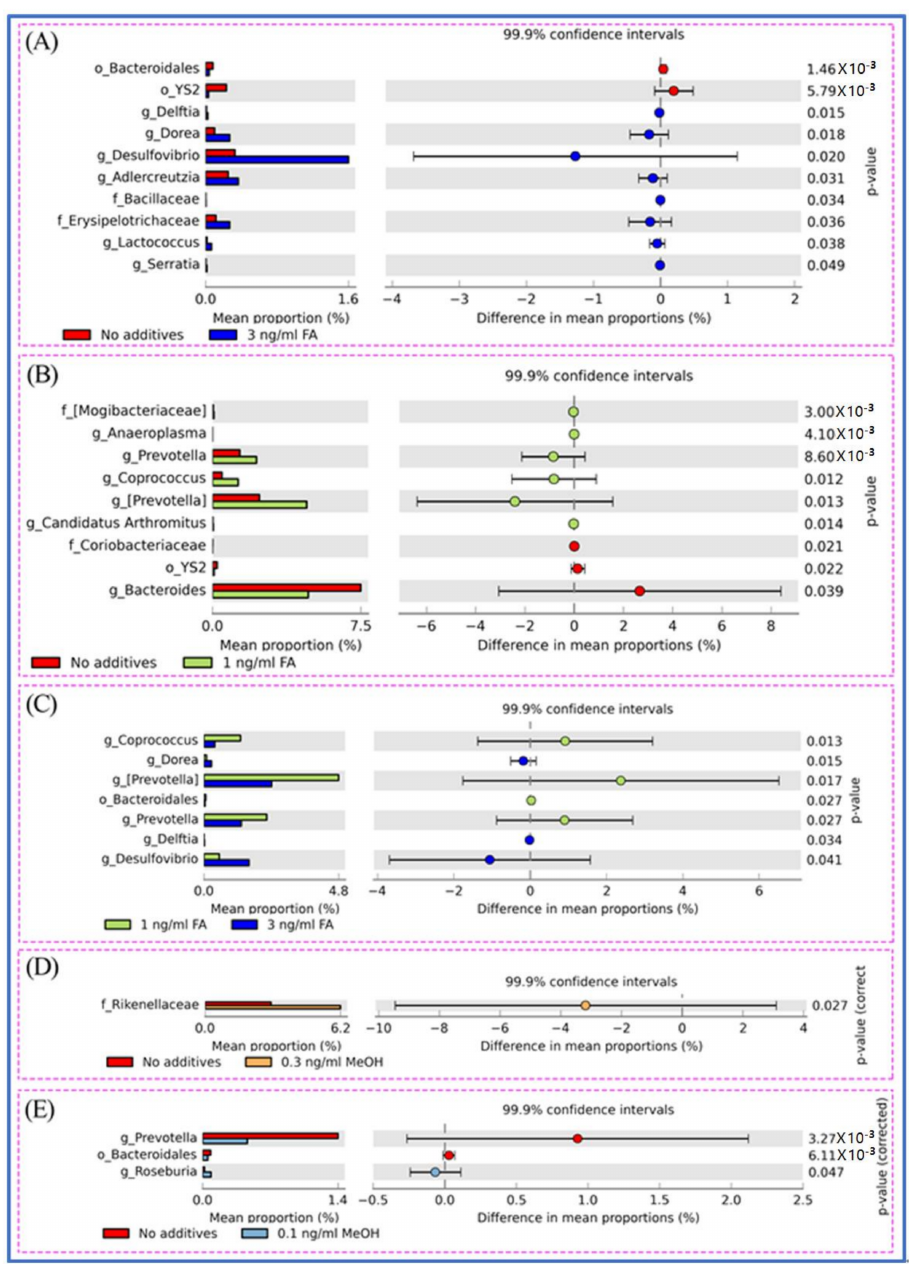
Figure 4. Different genera between untreated and FA treated mice detected by STAMP software [41]. ( A ) Different genera between untreated and the 3.0 ng/mL FA treated mice. ( B ) Different genera between untreated and the 1.0 ng/mL FA treated mice. ( C ) Different genera between the 3.0 and the 1.0 ng/mL FA treated mice. ( D ) Different genera between untreated and the 0.3 ng/mL MeOH treated mice. ( E ) Different genera between untreated and the 0.1 ng/mL MeOH treated mice. For each comparison, the mean proportion of genera ( left ) and difference in mean proportions ( right ) were